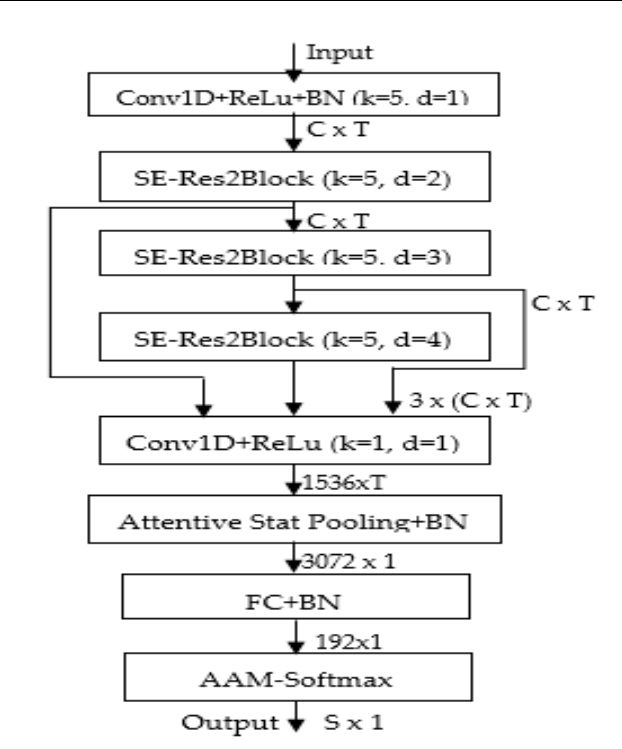
Figure 3. ECAPA-TDNN Architecture [9]. Figure 4. ECAPA-TDNN Architecture [9].